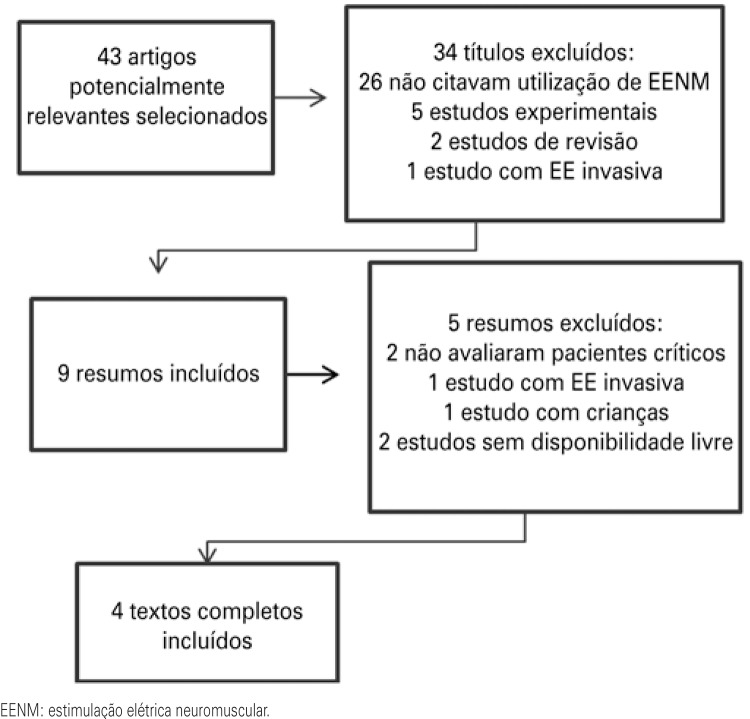
Fluxograma da estratégia de seleção dos artigos